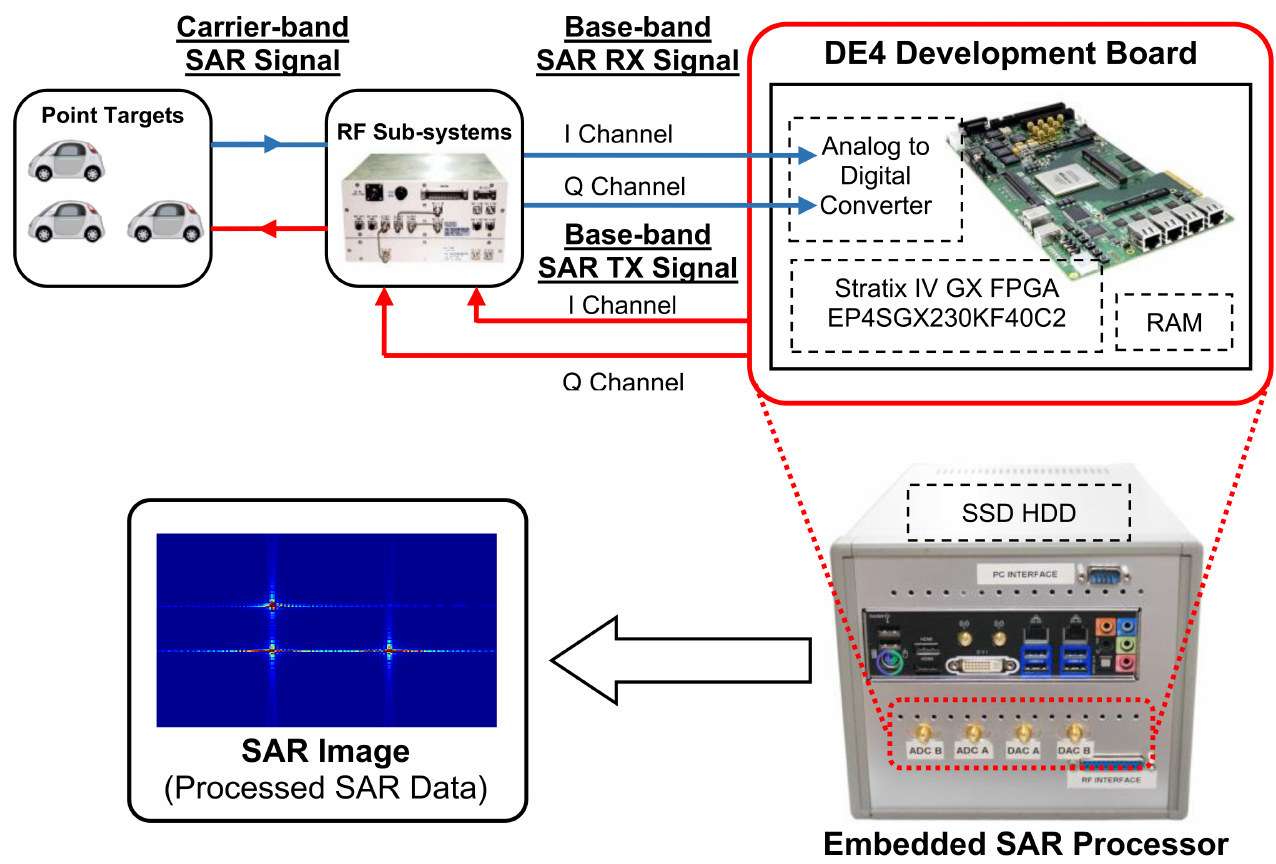
Figure 3. Overall block diagram for the hardware implementation of the FPGA-based SAR